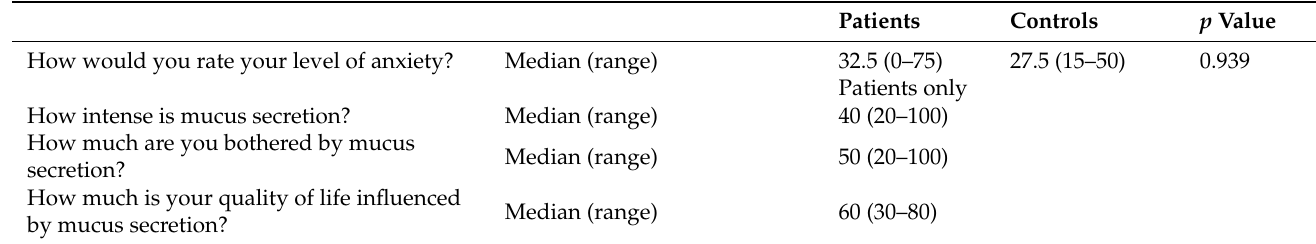
Table 5. Results from Visual Analogue Scale